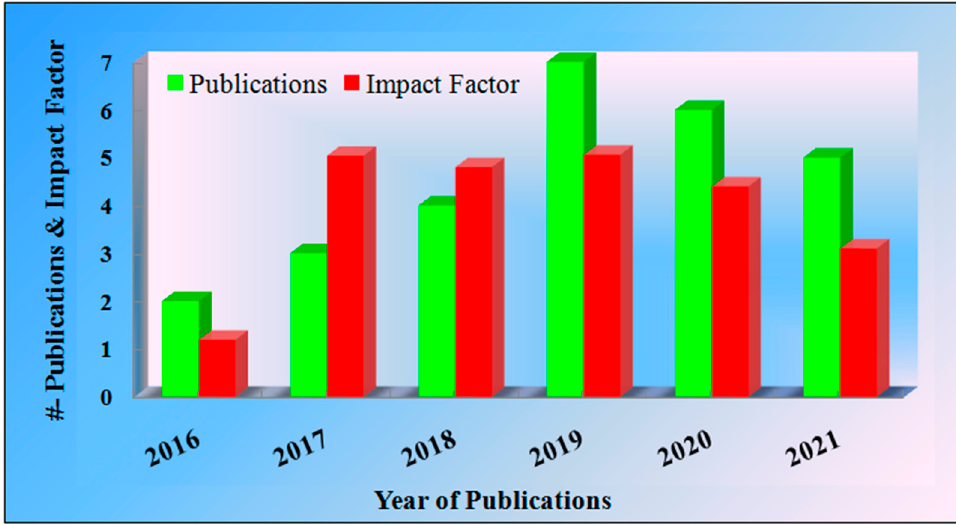
Figure 3. Year of article publication vs. impact factor.